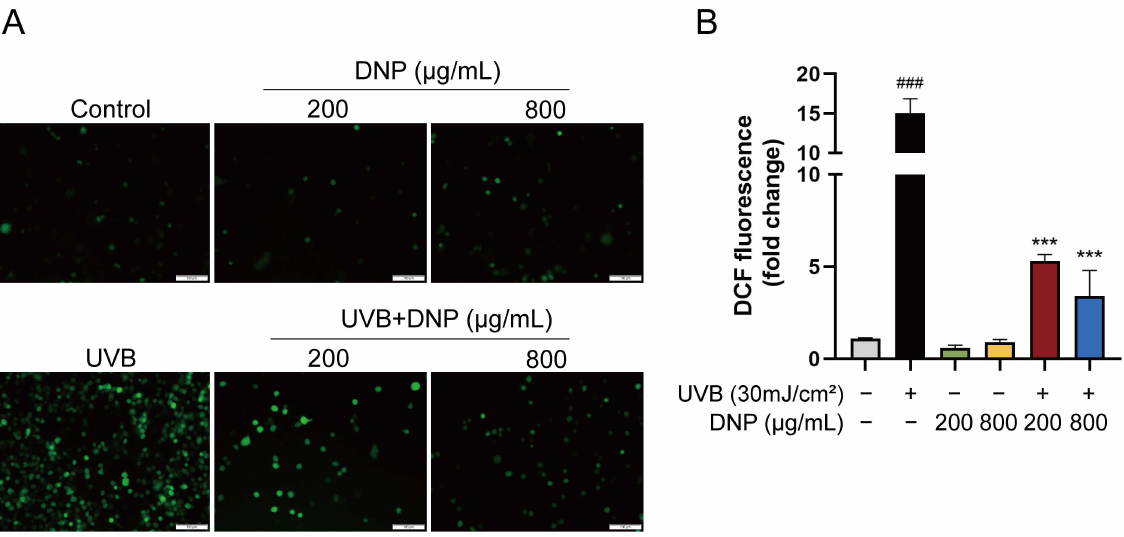
Figure 2. DNPs inhibit UVB-induced intracellular ROS generation. ( A ) Images of DCFH-DA fluo- rescence observed via microscopy. Scale bar = 100 µ m. ( B ) Quantification of fluorescence intensity. ### p < 0.001 vs. control group; *** p < 0.001 vs. UVB